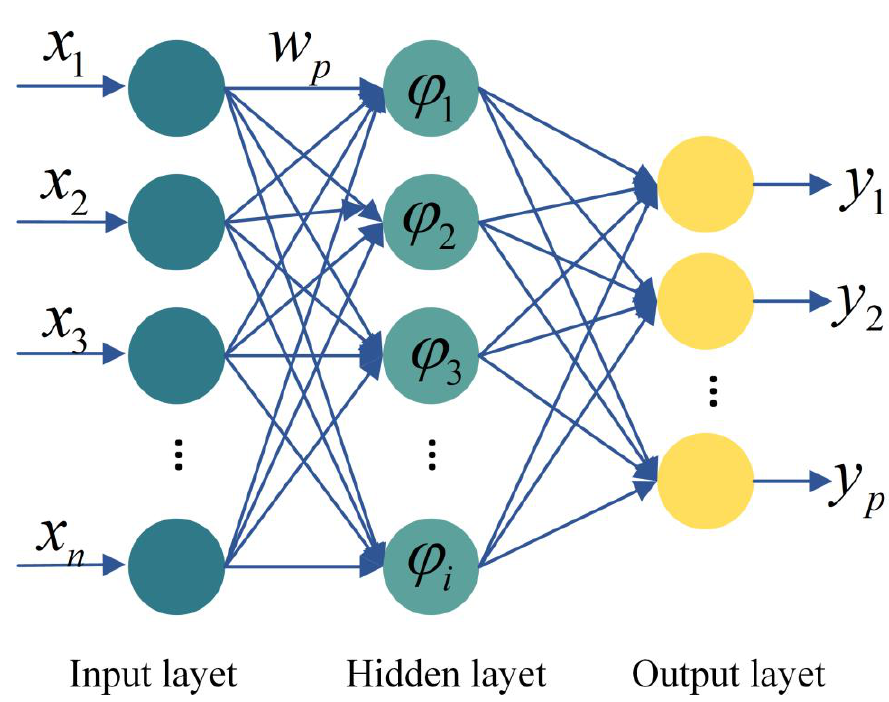
Figure 3. RBF network structure.